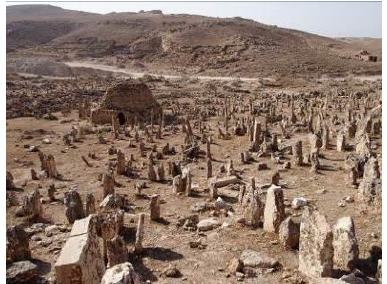
Figure 11 – Makhmúr al-Quadíma cemetery